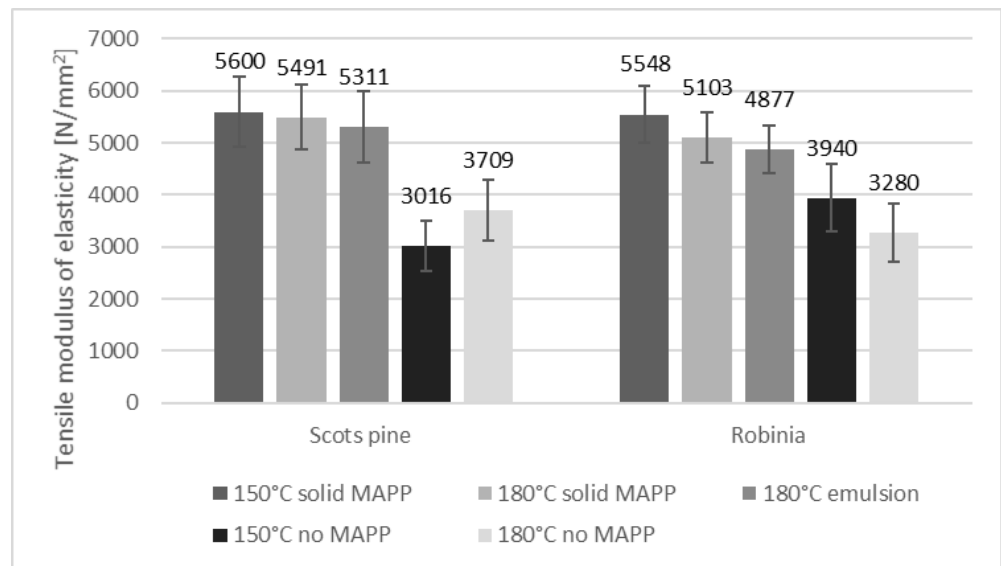
Figure 3. Tensile strength of composites with TMP based on Scots pine or Robinia. For compari- son, tensile strength of composites with wood flour (softwood) was 41 N/mm 2 including MAPP (solid) and 11 N/mm 2 excluding MAPP.